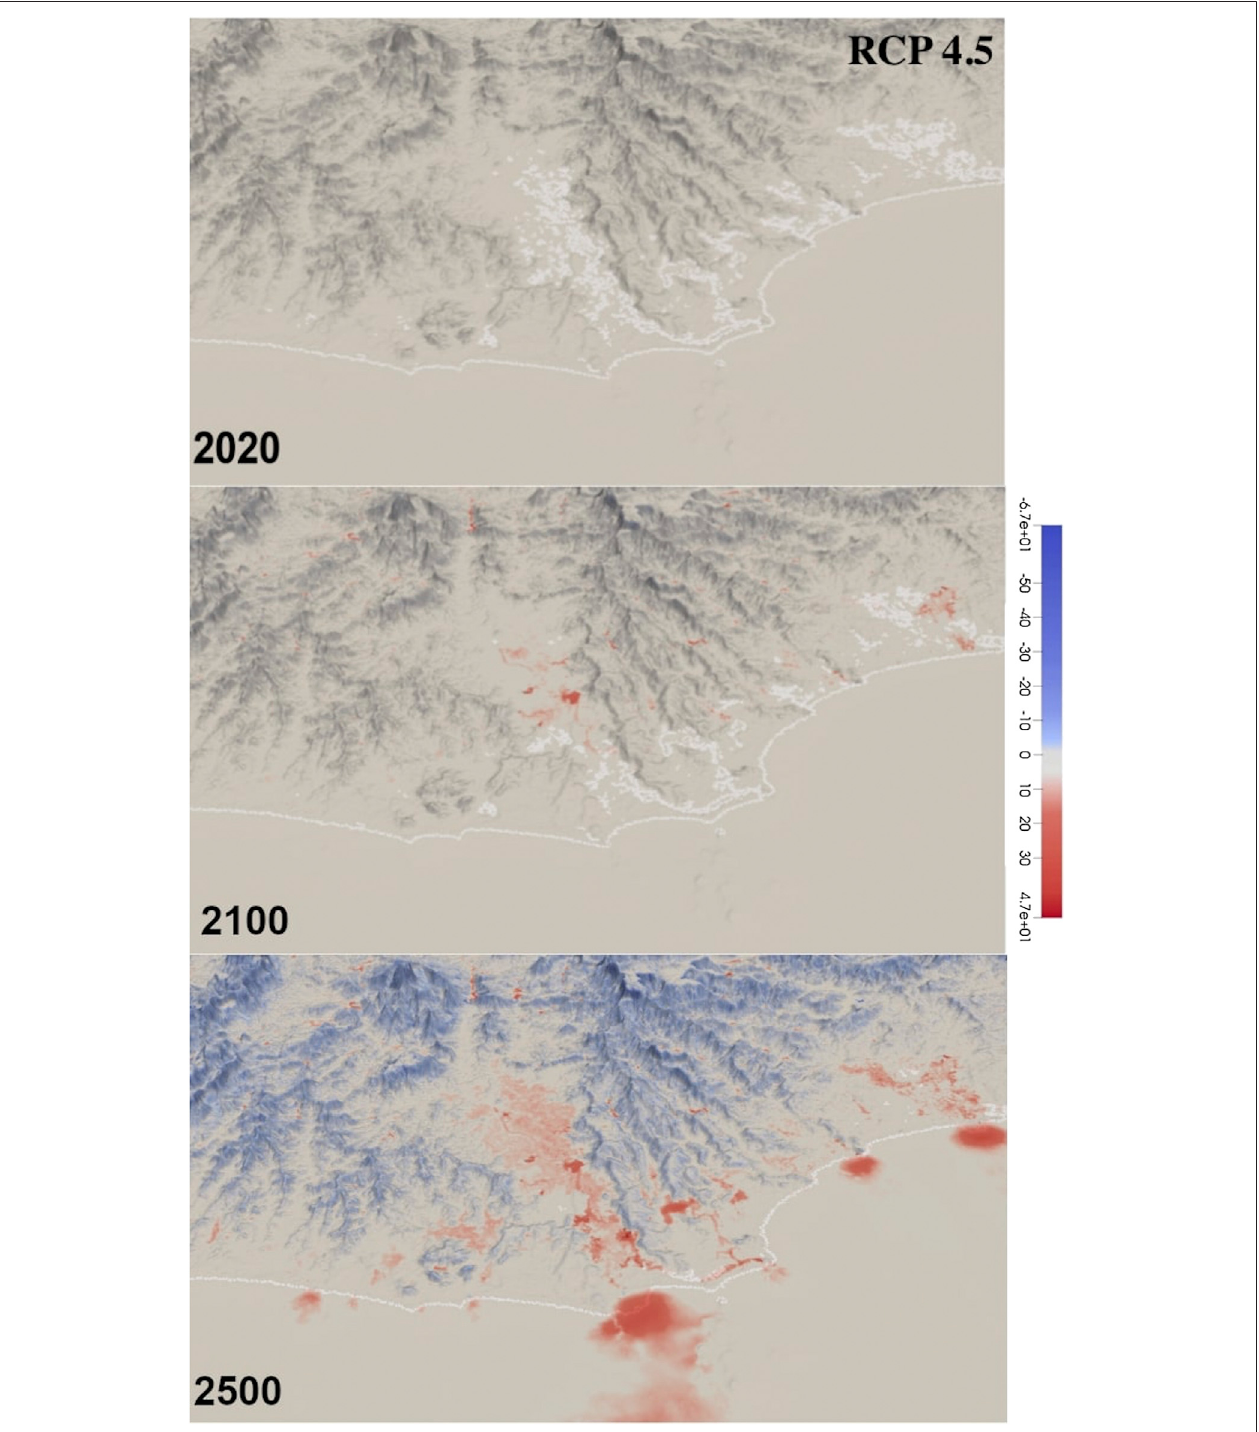
FIGURE 4 | Zoomed in regional visualization of the Tweed Valley fl oodplain region under Representative Concentration Pathways 4.5, illustrating the deposition of ma fi c sediment supply into erosive environments, and demonstrating the impact of sediment supply on local dynamics. Red areas indicate deposition and blue areas indicate erosion (m 2 /a).